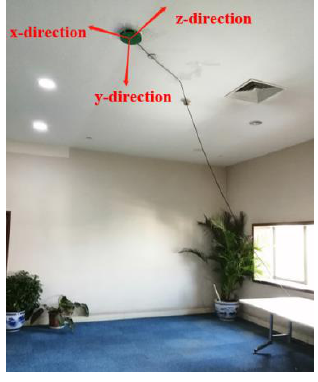
Figure 3. Test field image.